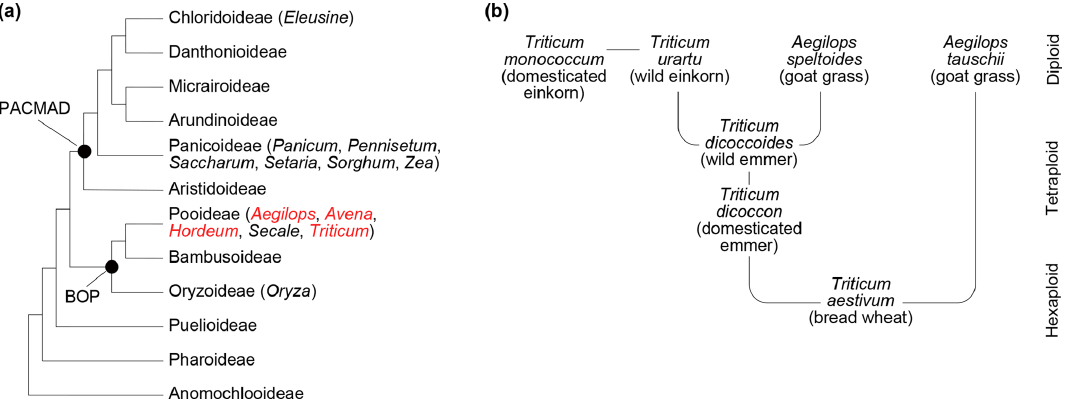
Figure 1. (a) Poaceae subfamily cladogram, redrawn from Soreng et al. (2015). BOP clade: subfamilies Bambusoideae, Oryzoideae and Pooideae. PACMAD clade: subfamilies Panicoideae, Aristidoideae, Chloridoideae, Micrairoideae, Arundinoideae and Danthonioideae. The genus names in parentheses are crop taxa mentioned in the text, and those in red are included in this study. (b) Hybridisation and domestication pathway for wheat, showing relationships among taxa and their ploidy levels. All taxa except Aegilops speltoides are included in this study (see also Table 1). Redrawn from International Wheat Genome Sequencing Consortium (2014), with additional information from Petersen et al.